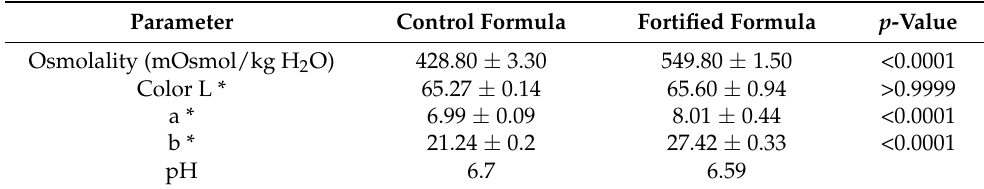
Table 3. Comparison of color, osmolality and pH in the control and fortified complete nutrition formulas after retort